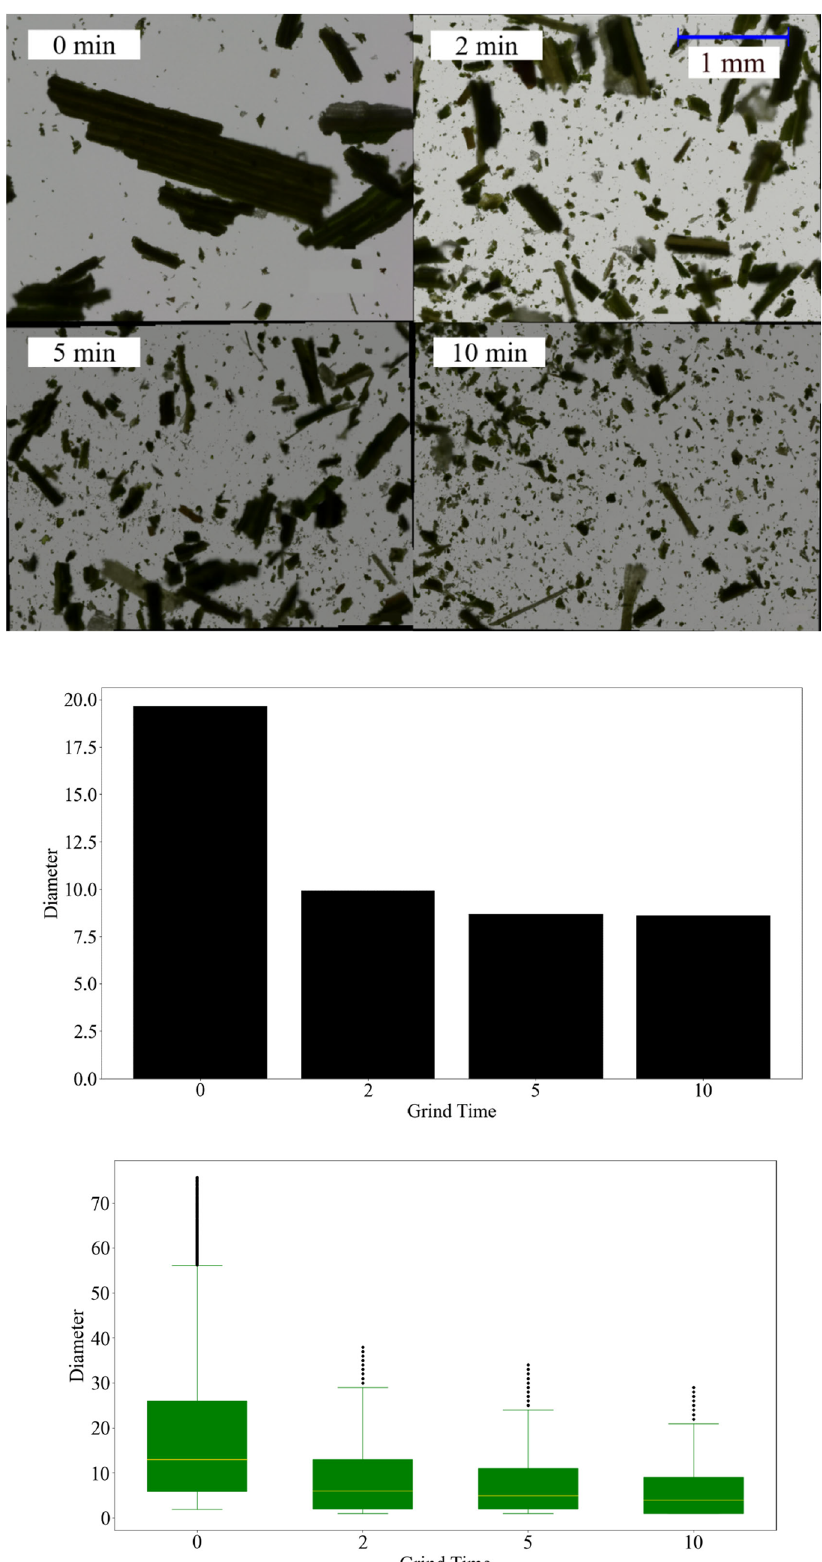
Figure 1. Top—Microscope images of dried rice leaf after 0, 2, 5, and 10 min of fine grinding. Middle—Average particle diameter (µm) of all plant species for each level of grinding (minutes). Bottom—Distribution of particle size for each level of fine grinding. Outliers are indicated by the black